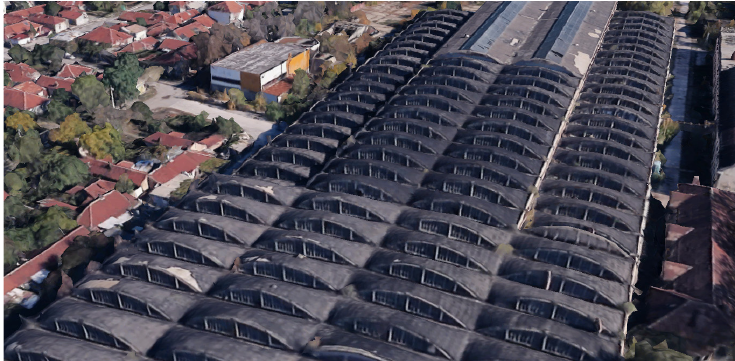
Figure 20. Recent aerial view of the Railway Depot by I. Doganoff.